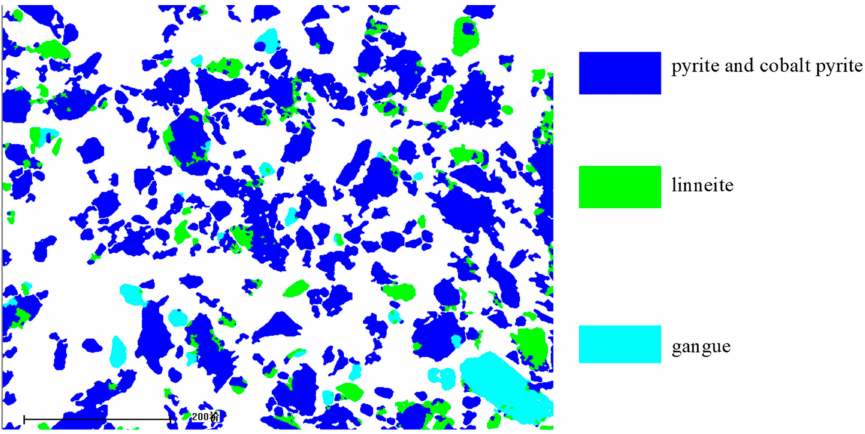
Figure 13. Mineral liberation analyzer (MLA) analysis images of cobalt–sulfur concentrate. Table 9. MLA mineral phase composition analysis of cobalt–sulfur concentrate. Mineral Phase